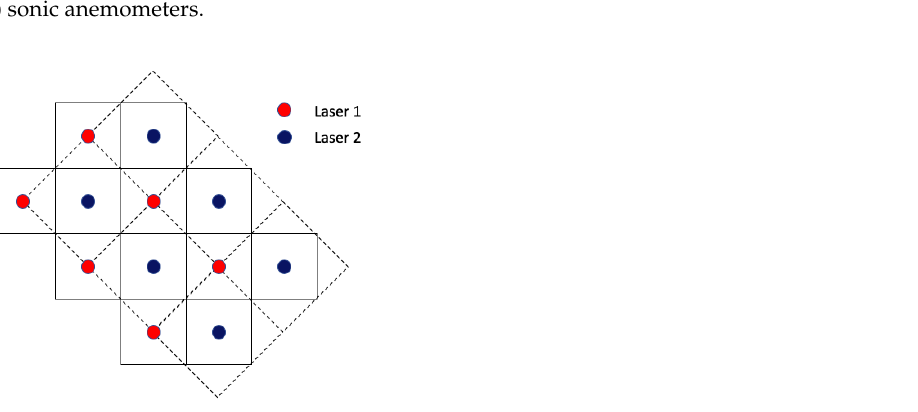
Figure 2. Experimental setup of the ( a ) Hartmann Turbulence Sensor, ( b ) dual laser beacons, and